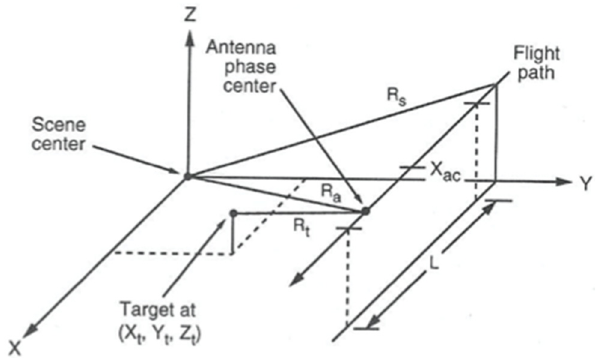
Figure 3. SAR geometry details (asf.alaska.edu, accessed on 20 October 2020).